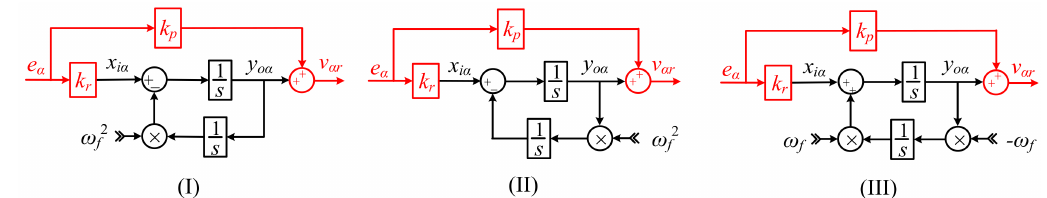
Figure 3. Detailed block diagrams of adaptive PR controllers with different implementations of R ( s ).